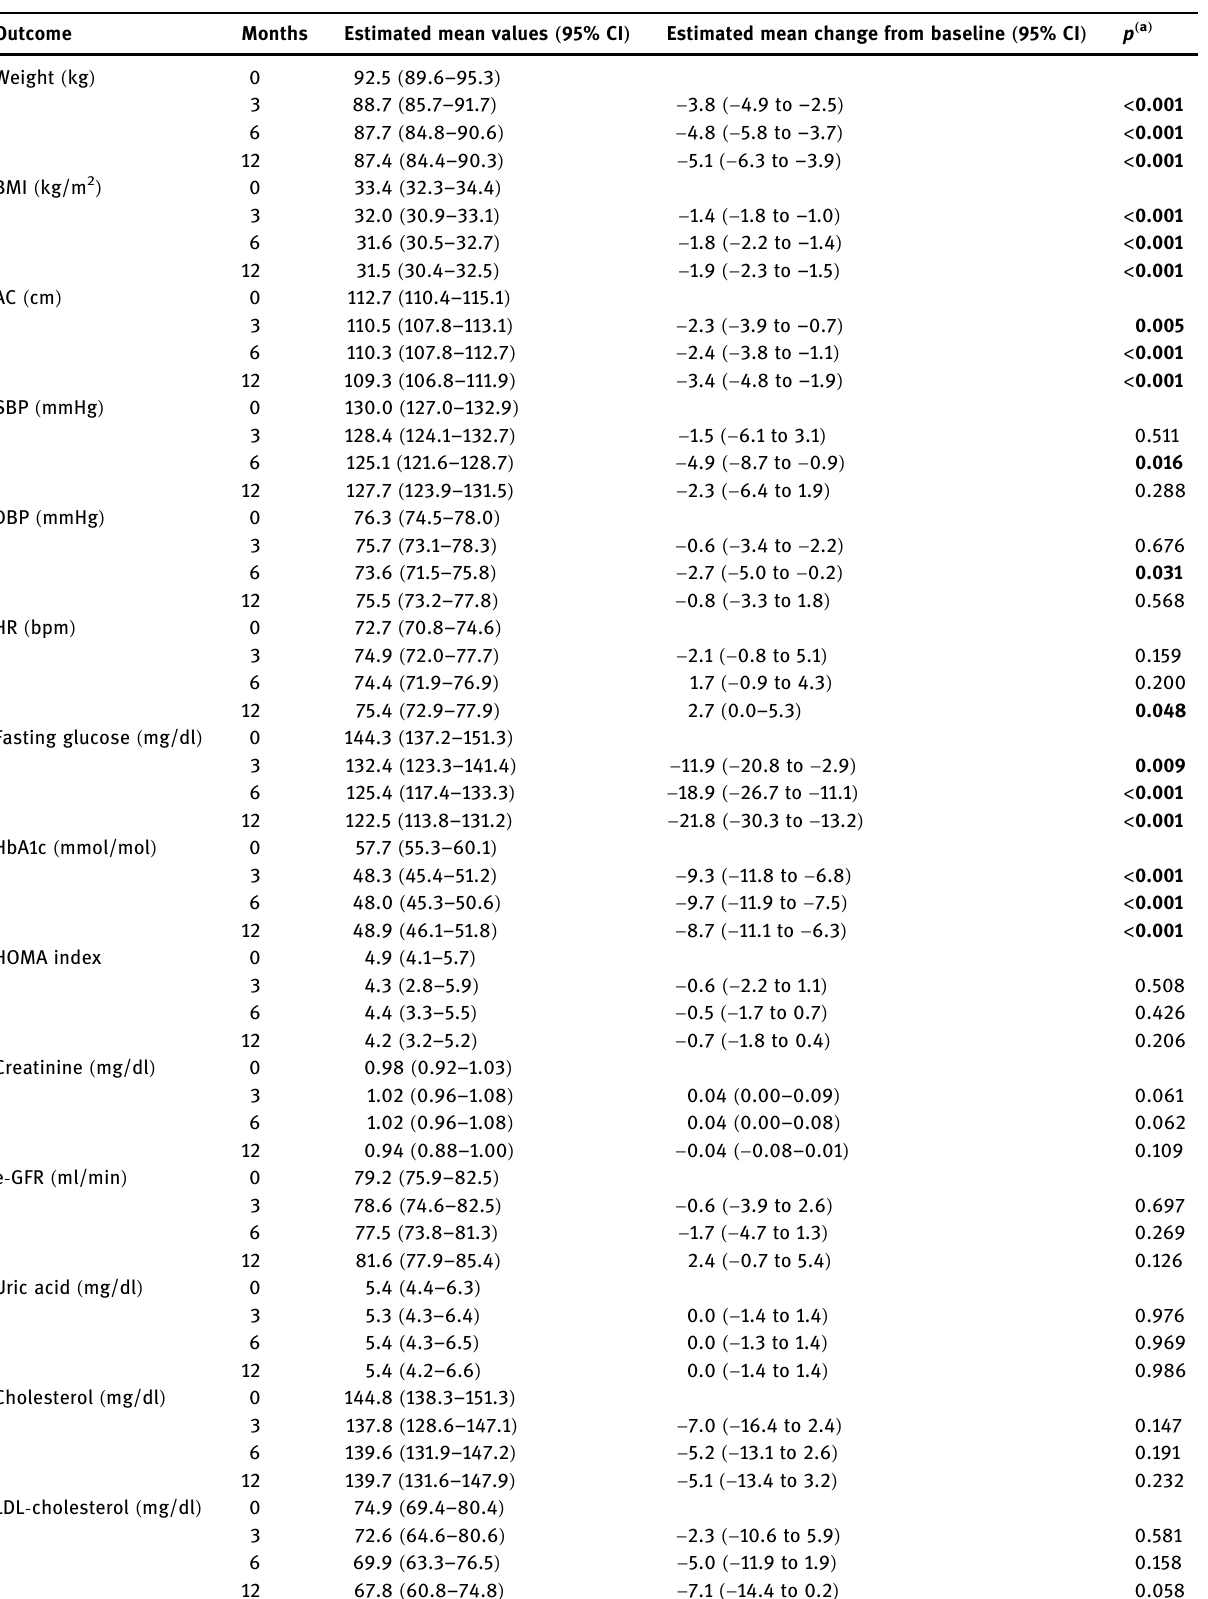
Table 4: Time trends of clinical parameters in patients treated with GLP1RA